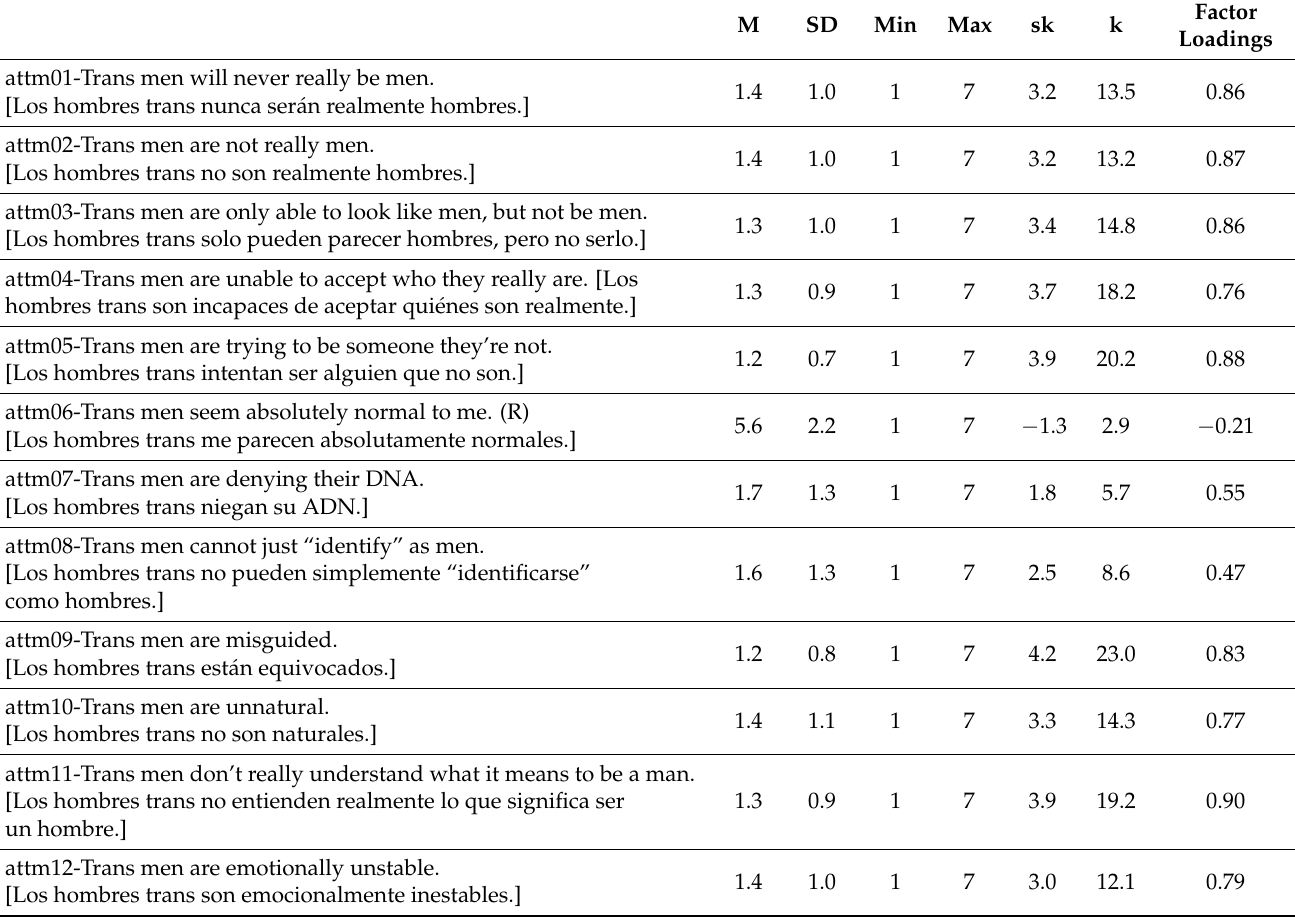
Table 1. ATTM Item Content, Descriptive Statistics, and Standardized Factor Loadings. M SD k